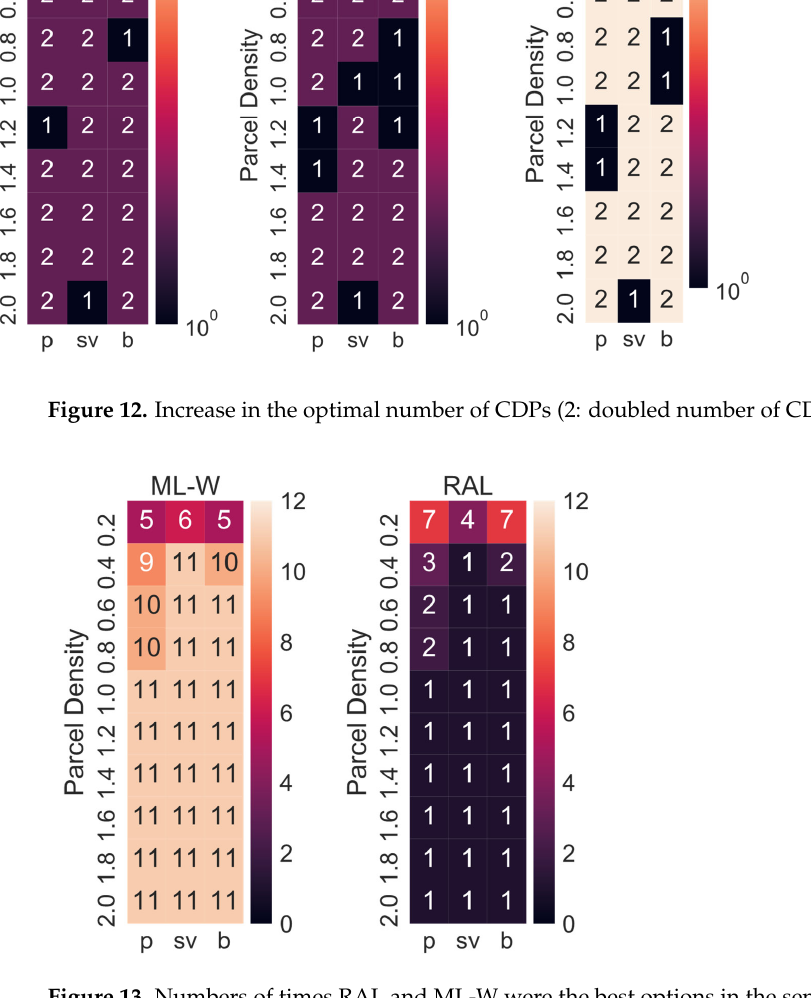
Figure 13. Numbers of times RAL and ML ‐ W were the best options in the sensitivity analysis.